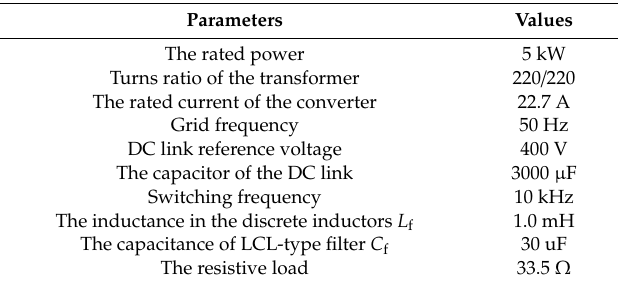
Table 3. Parameters of the HSTT and converter